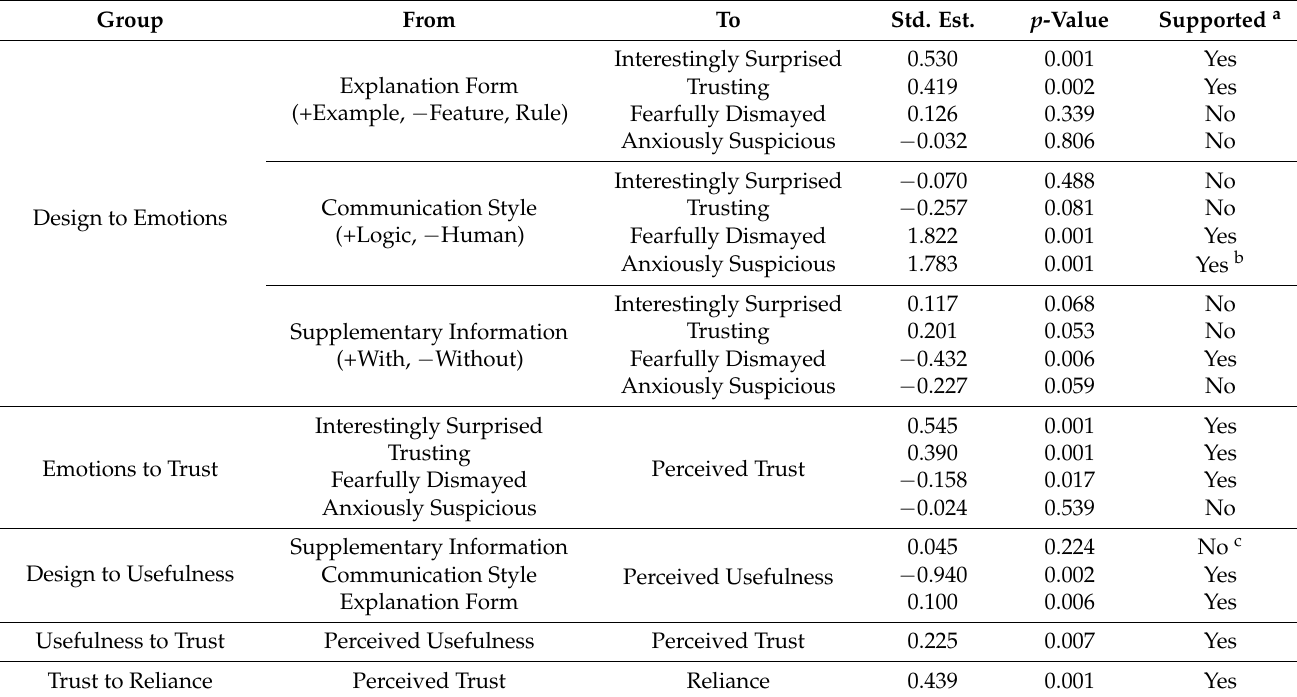
Table 9. Direct effect